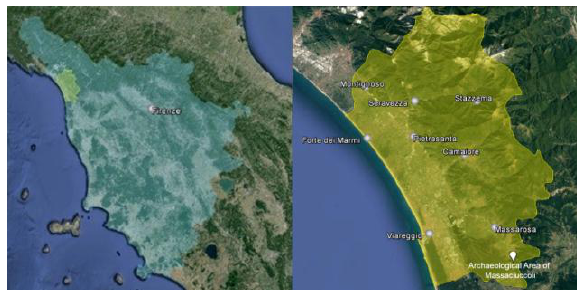
Figure 1. Location map of Versilia, the sub-region of Tuscany - Italy (left) where the research projects, named VisualVersilia and VisualVersilia 3D , were developed. A focus of Versilia territory with main towns